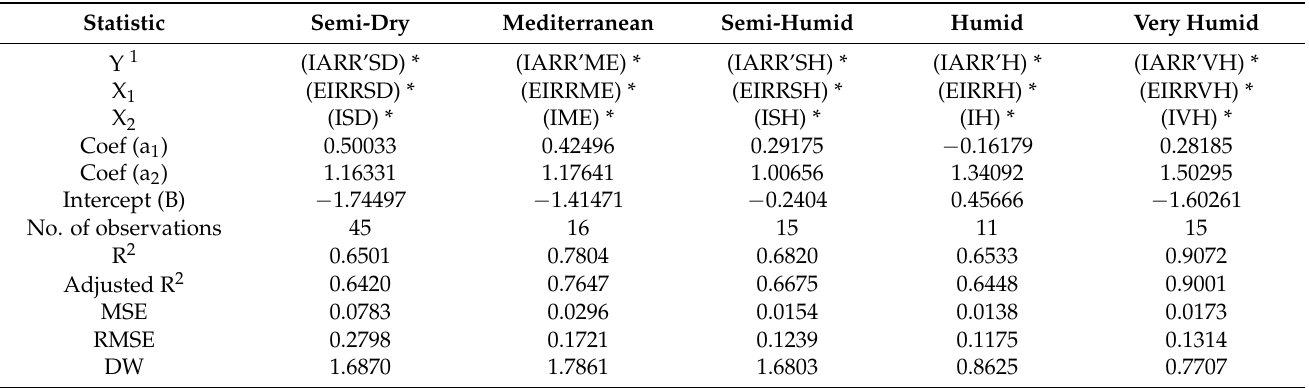
Table 5. Statistical parameters and performance tests of multiple regression models, obtained by ANN 2 for each bioclimatic floor in northern